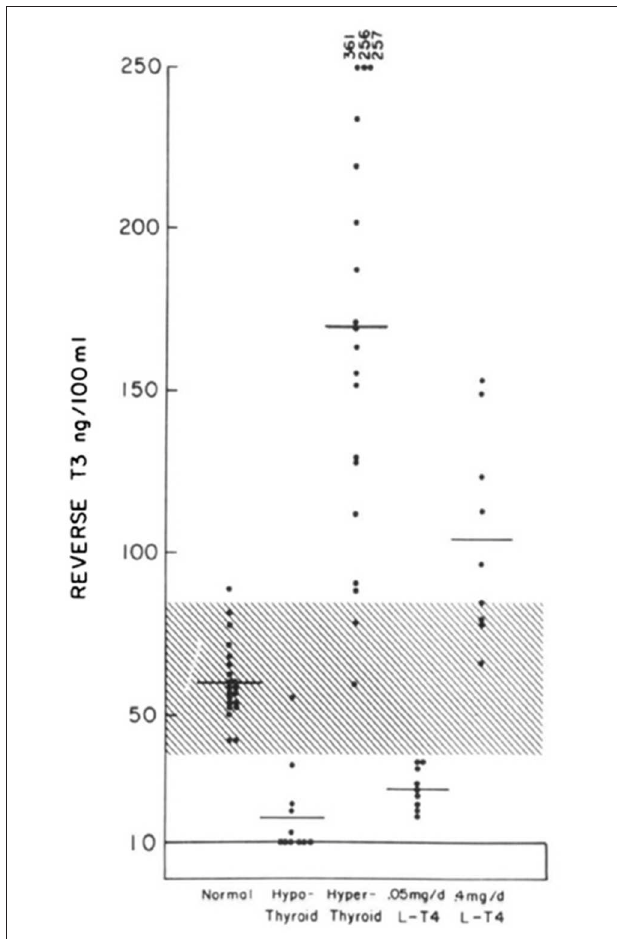
FIGURE 2 | Individual values of serum reverse T3 levels in normal, hypothyroid, and hyperthyroid subjects and in athyreotic patients who have been administered 50 mcg of LT4 and 400 mcg of LT4 daily [This figure was obtained with permission from Burman et al. (